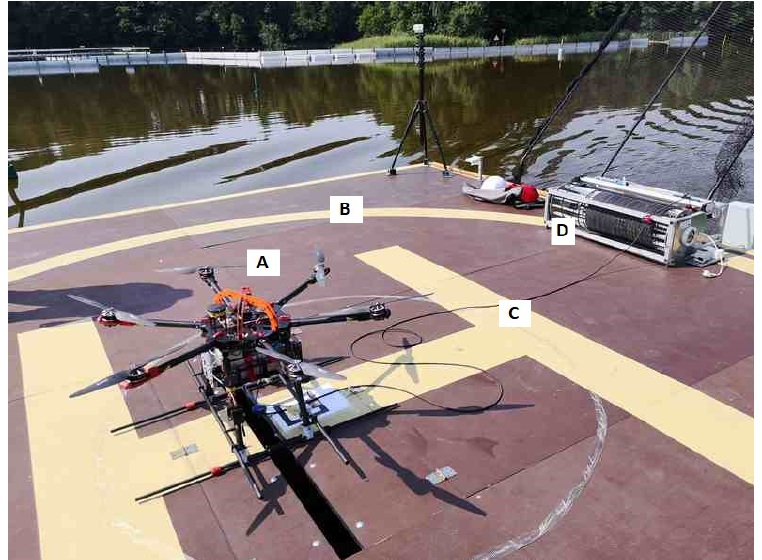
Figure 3. Mutlirotor UAV (A), landing pad (B), power cord (C) and automatic winch (D). Table 2. Multicopter